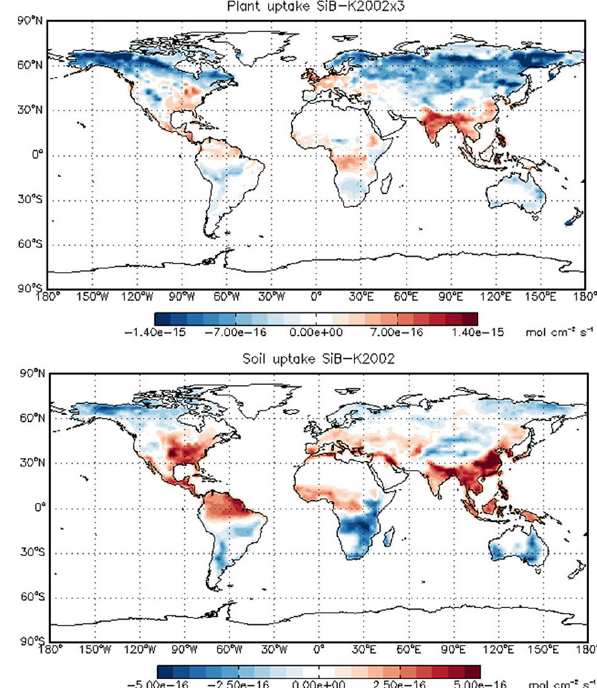
Figure 4. Difference between SiB OCS plant uptake and K2002x3 (top, SiB – K2002x3), difference between OCS soil uptake and K2002 (bottom, SiB –